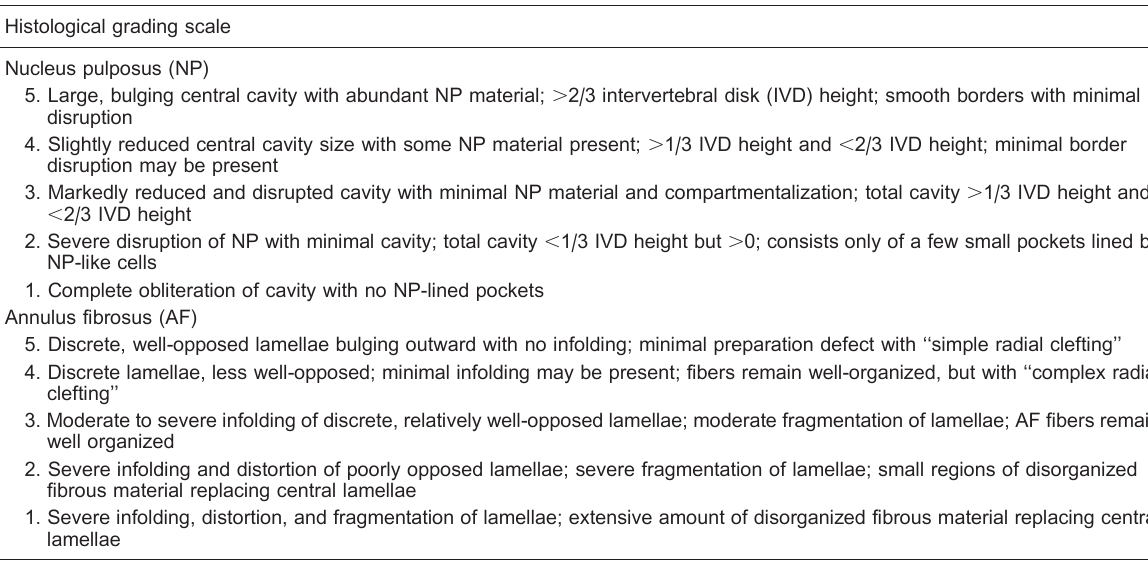
Table 1. Histological grading scale criteria based on Norcross et al.